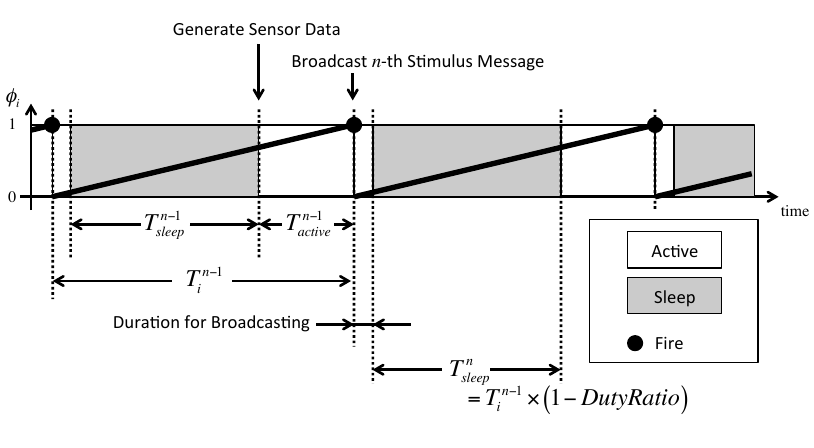
Figure 7. Duty cycling in